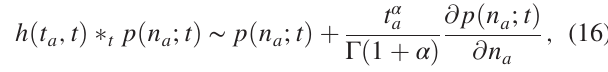
FIG. 3 (color online). Double logarithmic plots of the probability m α to observe any events during the measurement period ½ t (right) and the complementary probability 1 − m α (left), both as a function of age t Eq. (12). Note the initial power-law increase ð 1 − m α Þ ≃ ð t the values of t used for the plots in Fig. a